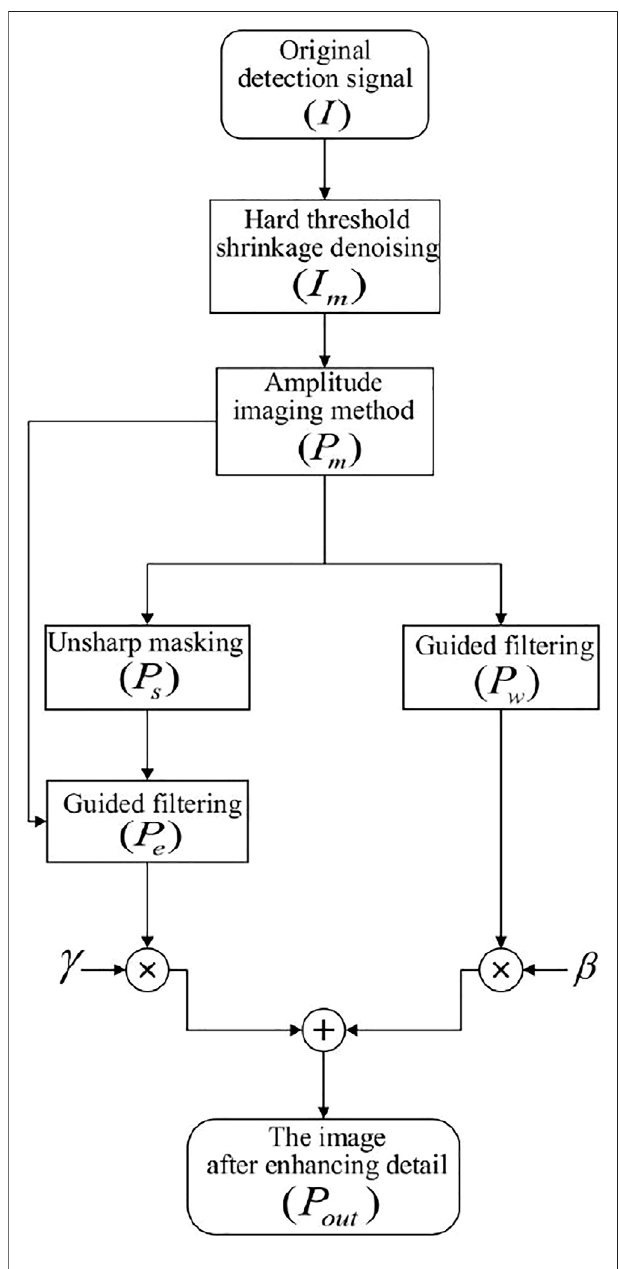
FIGURE2| Blockdiagramofterahertzimageprocessingmethodbased on wavelet unsharp masking and guided fi ltering technology.